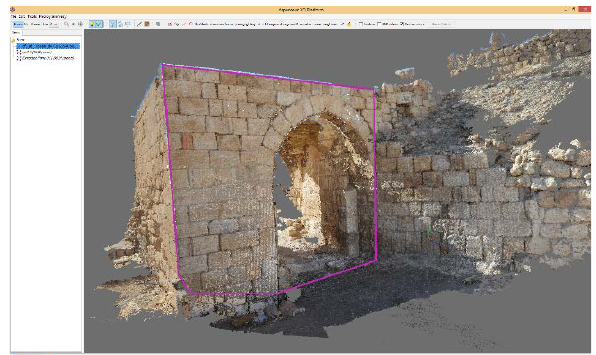
Figure 2 Bounding polygon (purple) and inner point (green), Castle of Shawbak, Jordan